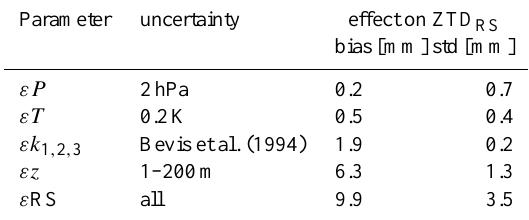
Table 3. Sensitivity of ZTD RS to the uncertainties of pressure ( εP ), temperature ( εT ), refractivity constants ( εk 1 , 2 , 3 ) , altitude estima- tion ( εz ), and all parameters simultaneously ( ε RS). Units are mm.